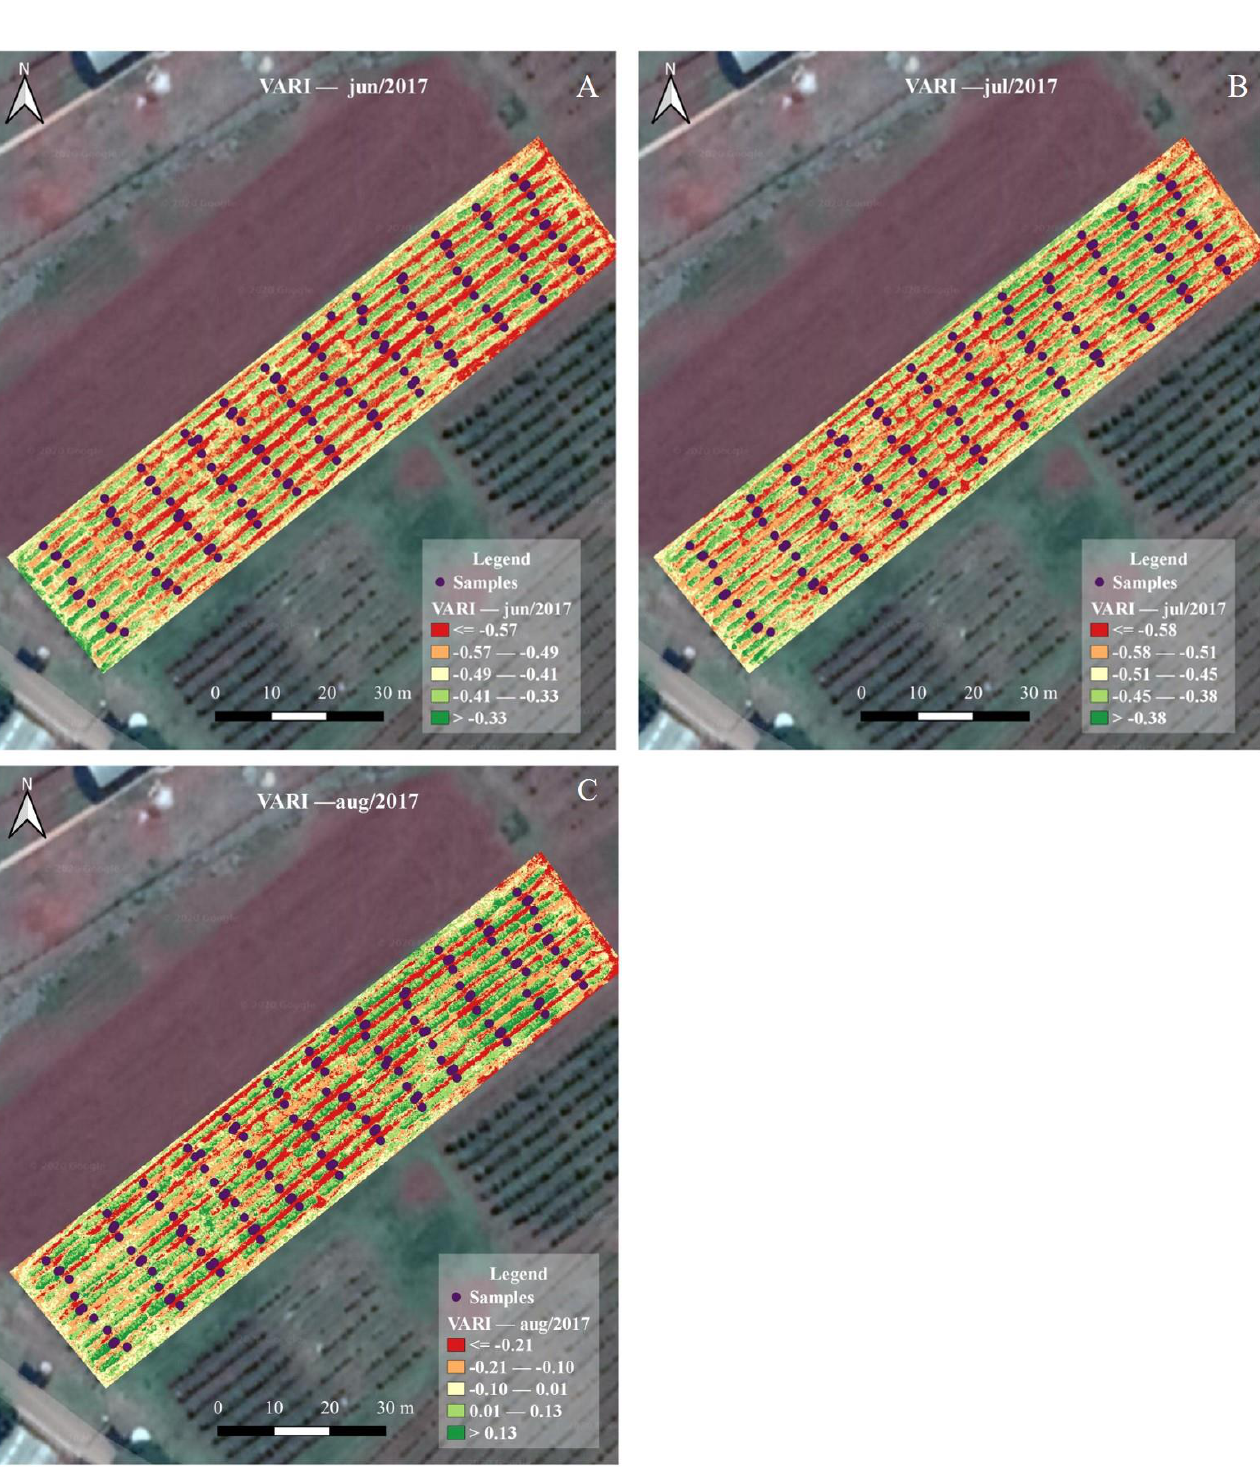
Figure 7. Second phase of the vegetative cycle of coffee evidenced by the VARI: ( A )—VARI/june, ( B )—VARI/july, ( C )— VARI/august.